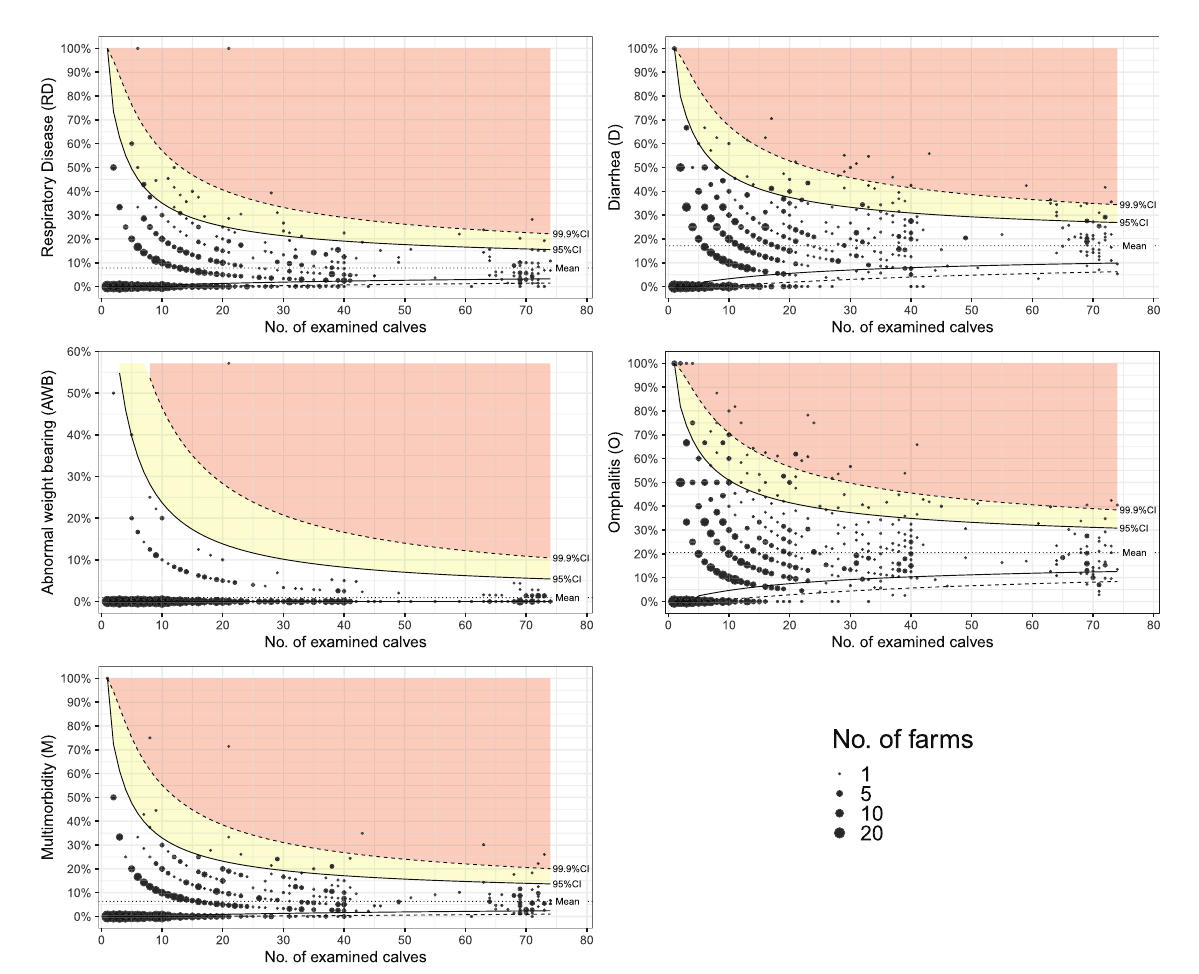
FIGURE1 Prevalence of disorders stratified by number of examined preweaned dairy calves on the farm. The dotted line marks the mean, the solid line marks the upper and lower 95% CI, and the dashed line marks the upper and lower 99.9% CI. In cases of sporadic occurrence, not more than 1 in 20 farms should lie outside of the interval for 95% CI (yellow marked area) and not more than 1 in 1,000 for 99.9% CI (red marked area). The size of the spots represents the number of farms with the similar prevalence of disorders and number of examined calves. Therefore, there are more farms included, as the size of the dot